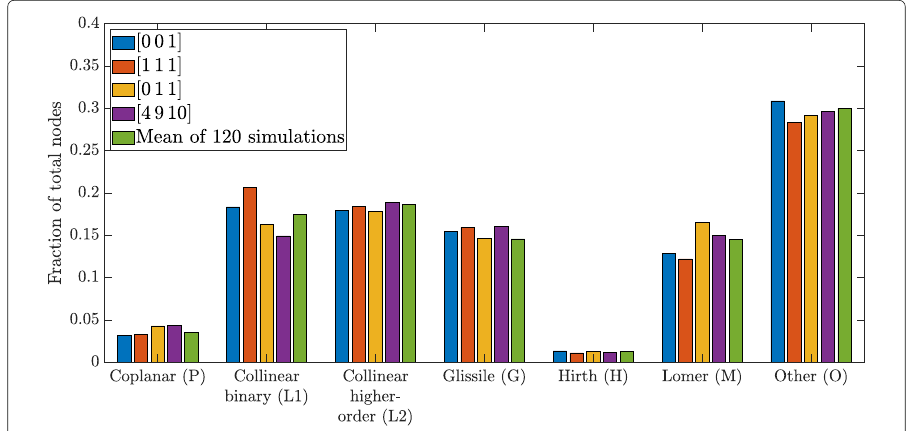
Fig. 8 Distribution of dislocation node types from network configurations at γ d = 0.5%. In each microstructure the total number of nodes is in the range of 3500–9000. See text for node type